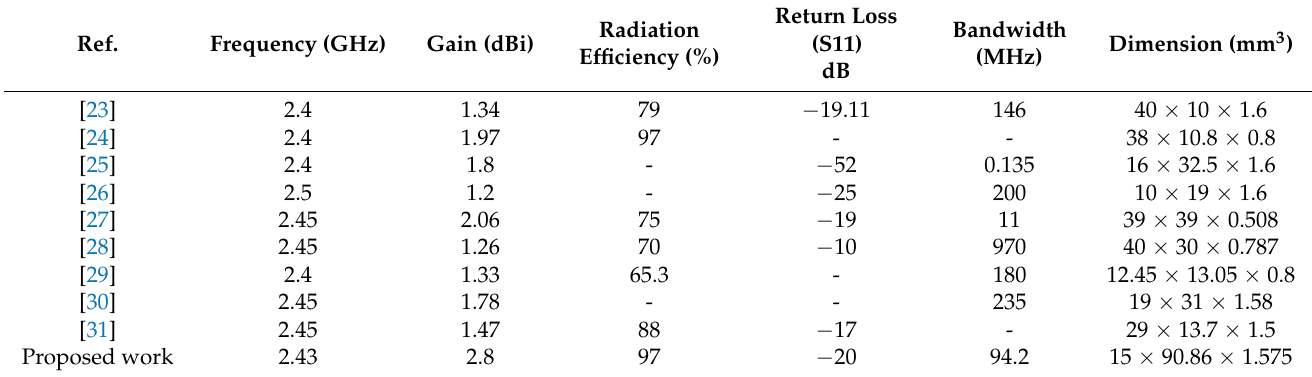
Table 1. A comparison of the recent literature concerning the proposed design.